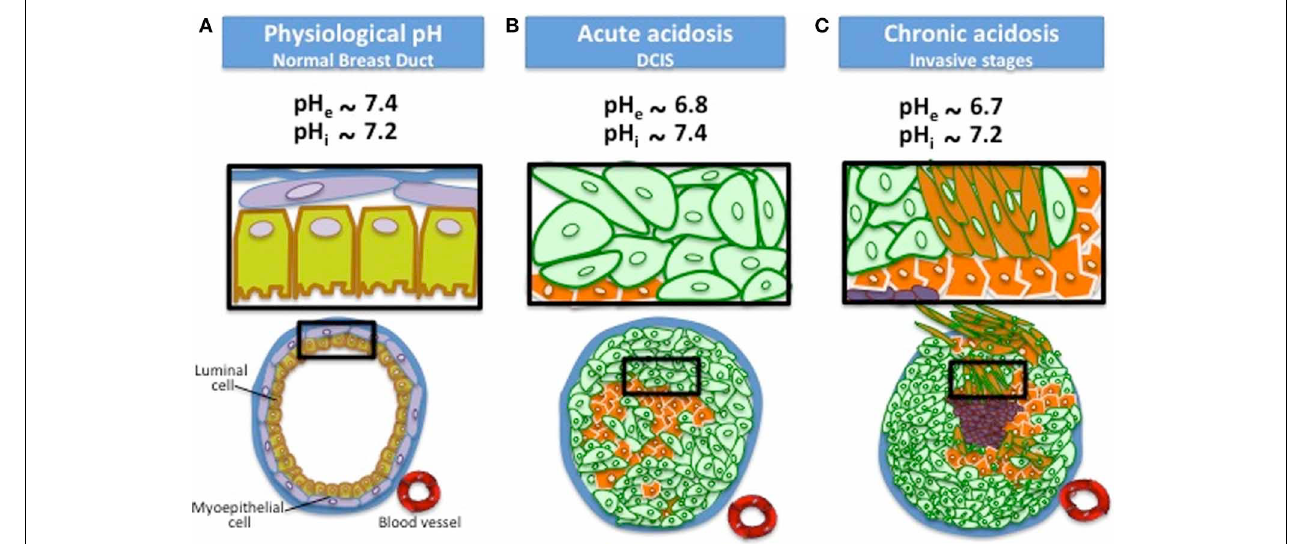
FIGURE 1 | Reversed extracellular and intracellular pH in cancer cells compared to normal cells. Cancer cells have a reversed pH gradient compared with normal differentiated cells that is cancer cells have a higher pH i and a lower pH e than normal cells in acute acidosis conditions. The pH e